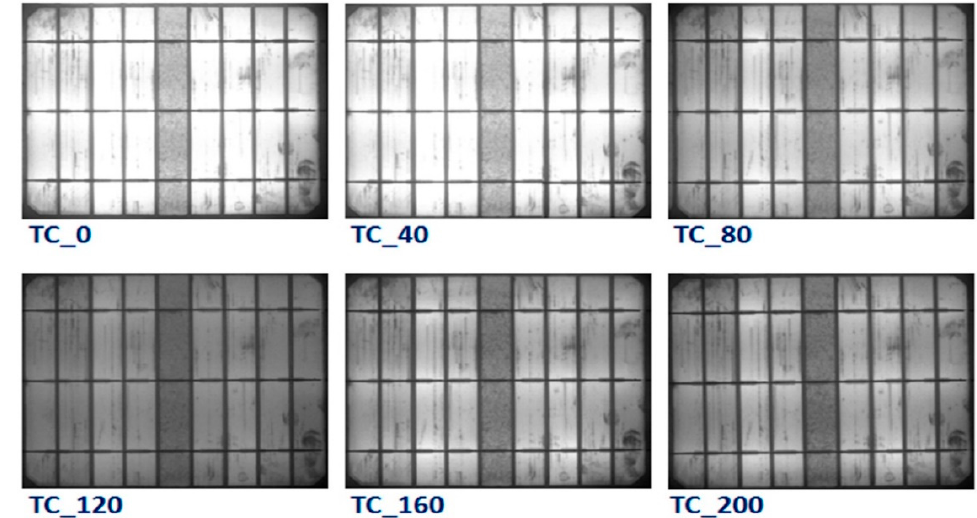
Figure 15. EL images of PV modules with concrete after various thermal cycling tests (0, 40, 80, 120, 160, and 200 cycles) [67].